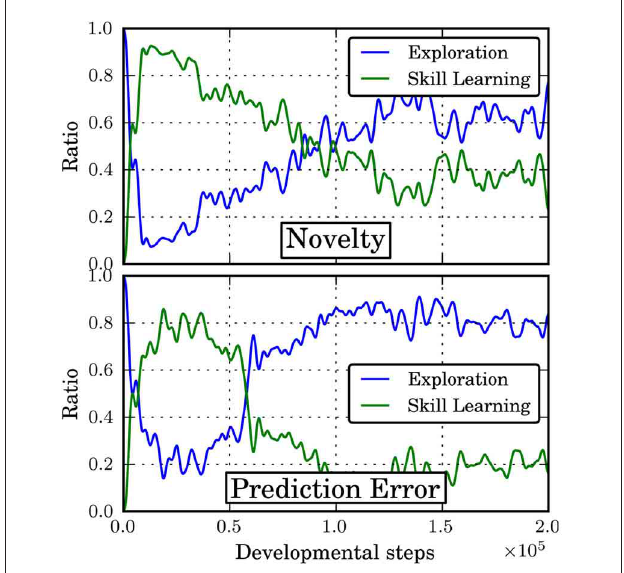
FIGURE 6 | Ratio of skill learning to exploration during developmental period. Shown is mean over 10 independent runs.